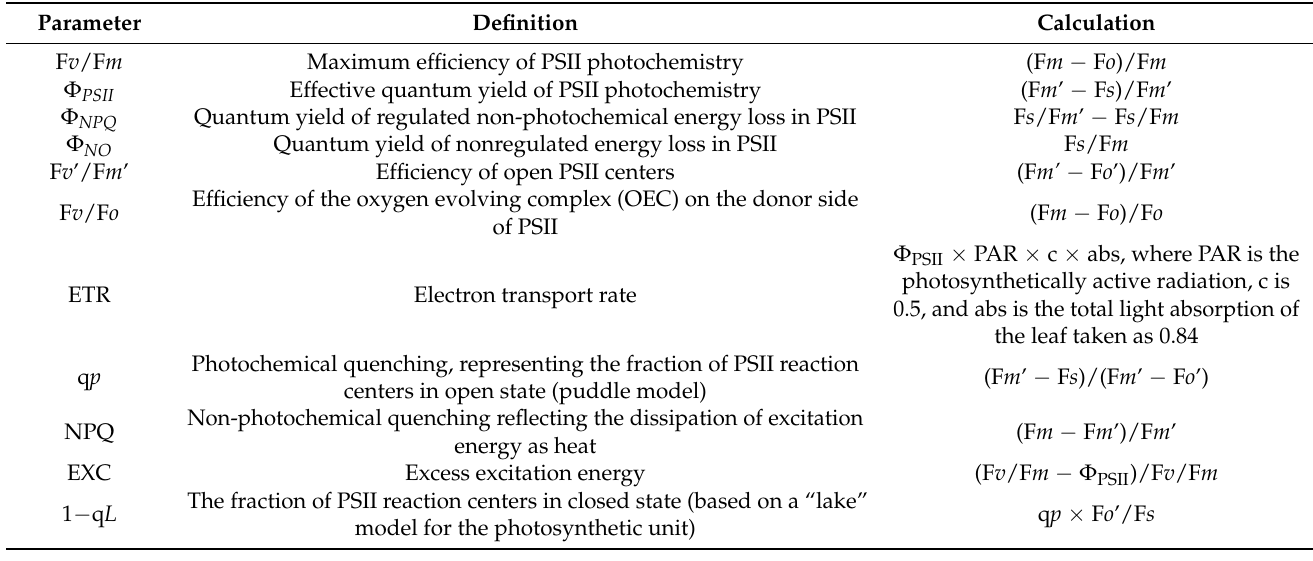
Table 1. Chlorophyll fluorescence parameters used in studies of photosystem II photochemistry with their